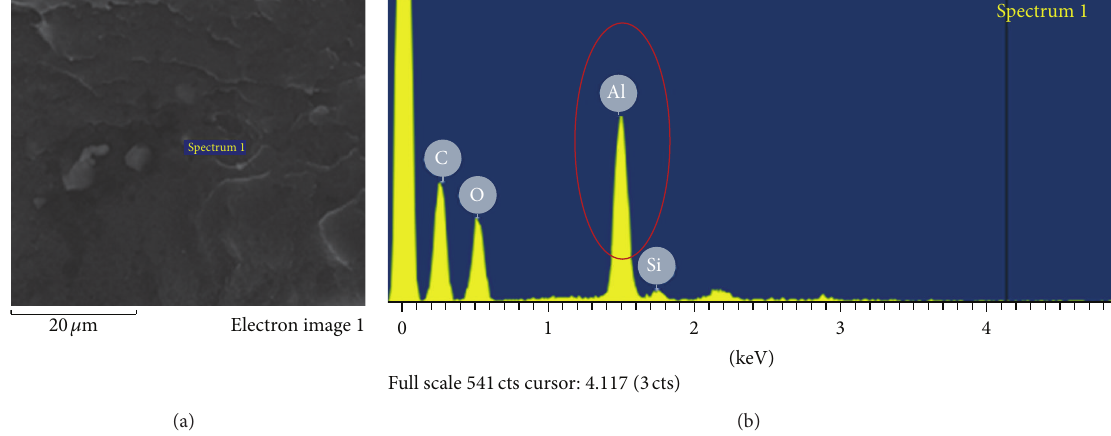
Figure 4: Elemental EDS analysis of fracture surfaces. Punctual sampling in (a) gives rise to the spectra reported in (b).